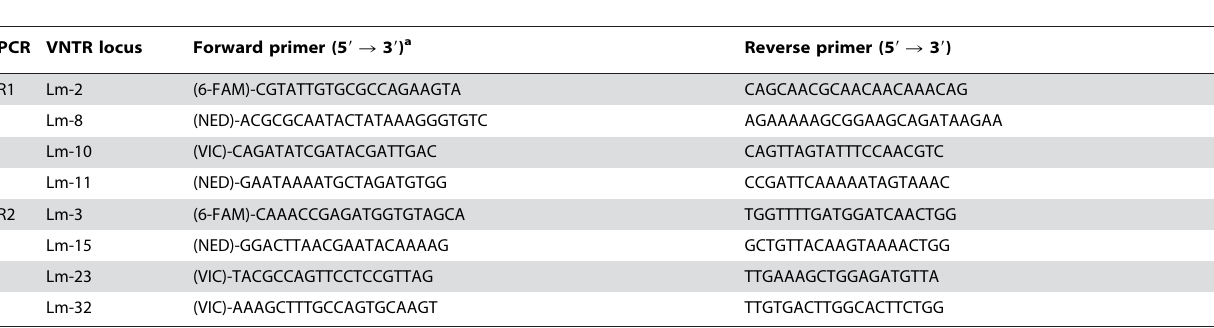
a Dye is shown in parentheses before primer sequence.